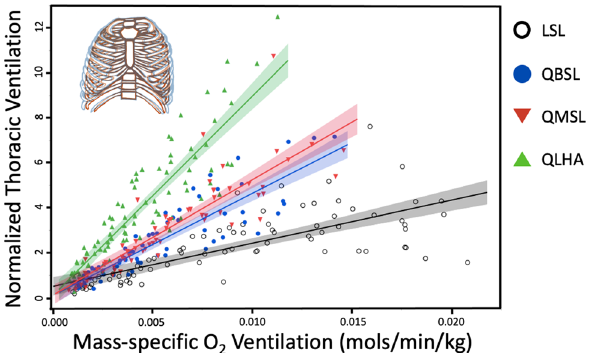
Figure 5. Normalized thoracic ventilation (the amount air inhaled per minute using the chest normalized to average chest volume) increases with mass-specific O 2 ventilation (moles/min/kg) in QLHA participants (slope ± S. 885.01 ± 34.82, R 2 = 0.80), QMSL (527.98 ± 24.99, R 2 = 0.78), QBSL (445.90 ± 22.99, R 2 = 0.78) and LSL participants (241.23 ± 16.05, R 2 = 0.55). Shading represents 95% CIs. Multiple measures from individual participants are presented together for graphical clarity. Repeated measures in participants are accounted for and fixed effects assessed via non-linear mixed effects models using generalized least squares (see “Statistical